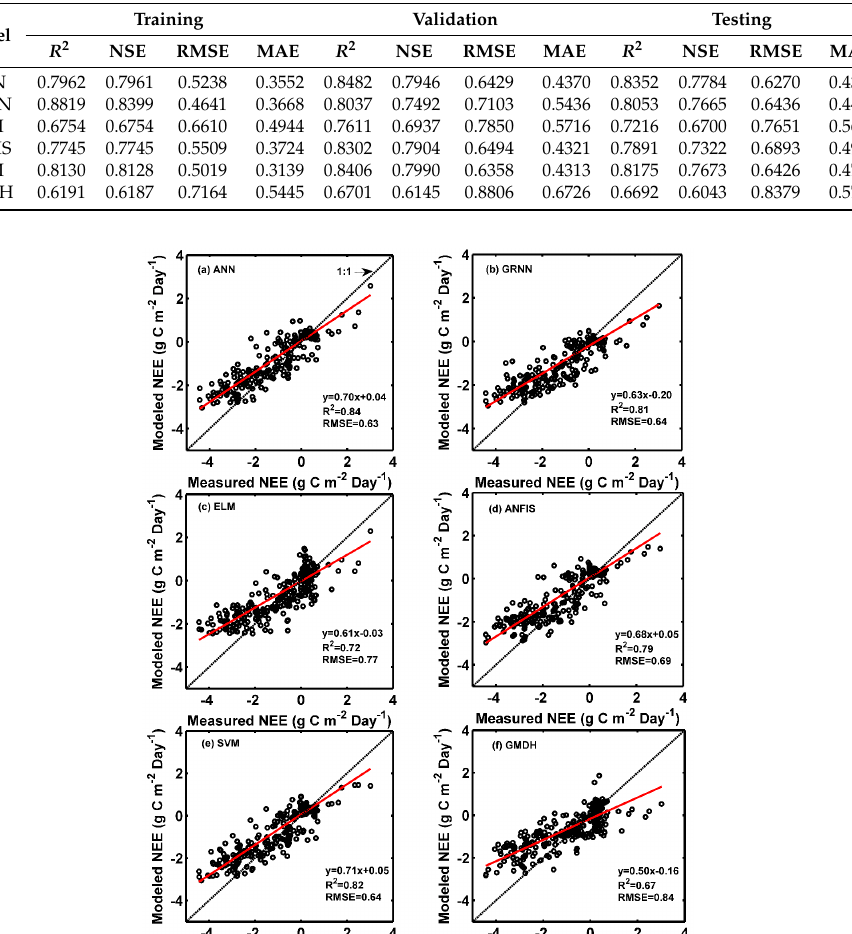
Table 6. Comparisons of data-driven models for evapotranspiration (ET, mm·Day − 1 ) for the training, validation and testing periods.